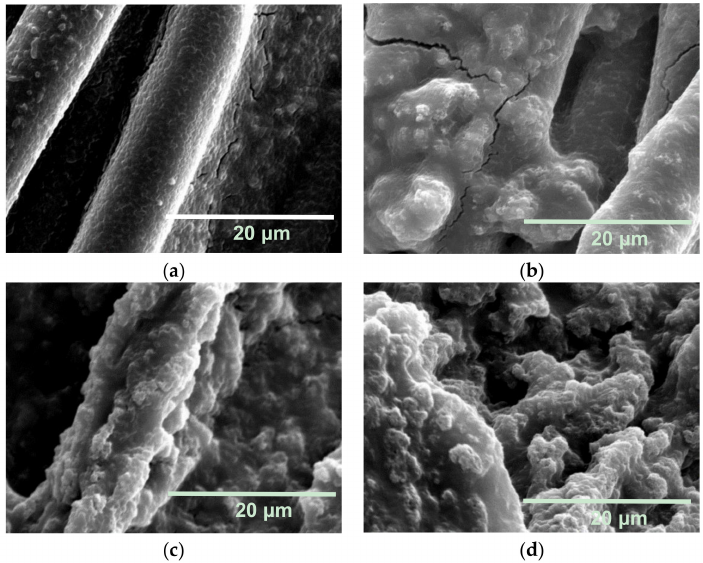
Figure 8. SEM images of the surfaces of the ( a ) unmodified carbon cloth and those modified by ( b ) 20, ( c ) 60, and ( d ) 120 s of candle sooting after immersion in the chambers of the MFCs for 24